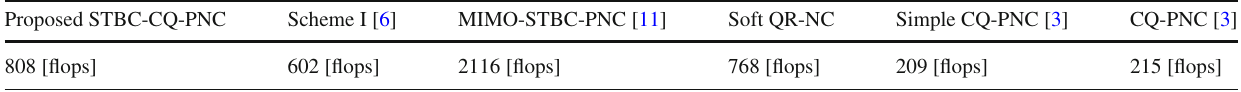
Table 1 Computational complexity comparison Proposed